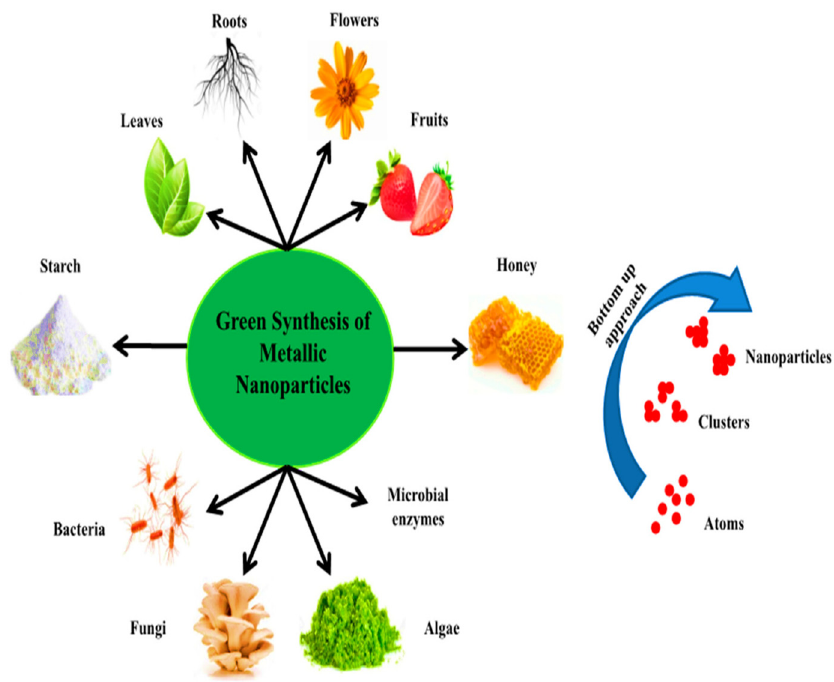
Figure 3. Different sources for green synthesis of metal NPs. Reprinted from Kumar et al., 2020 with permission of International Journal of Molecular Sciences, 2020. Copyright 1996–2022 MDPI (Basel, Switzerland) [114].